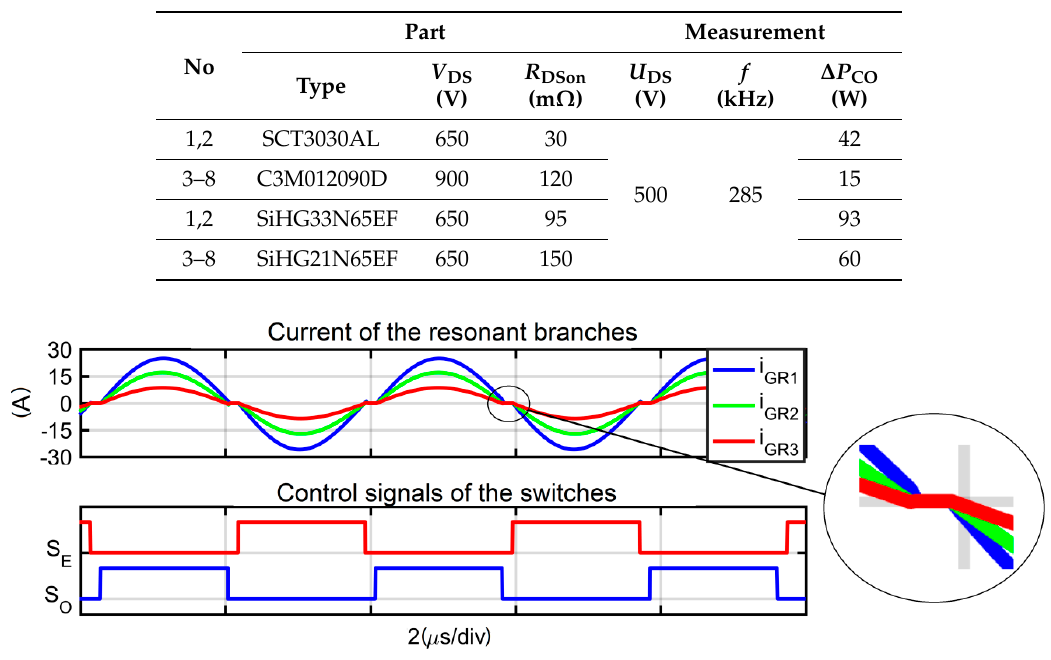
Figure 2. Simulation result of the 5 kW 500V/2 kV MRSCC (Multilevel Resonant Switched Capacitor Converter) in the base configuration in MATLAB/Simulink without C oss .